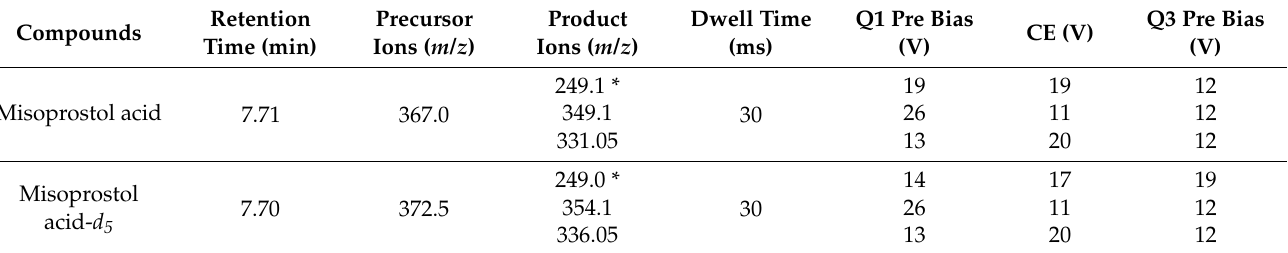
Table 1. UHPLC–ESI-QqQ-MS/MS parameters for misoprostol acid and misoprostol acid -d 5